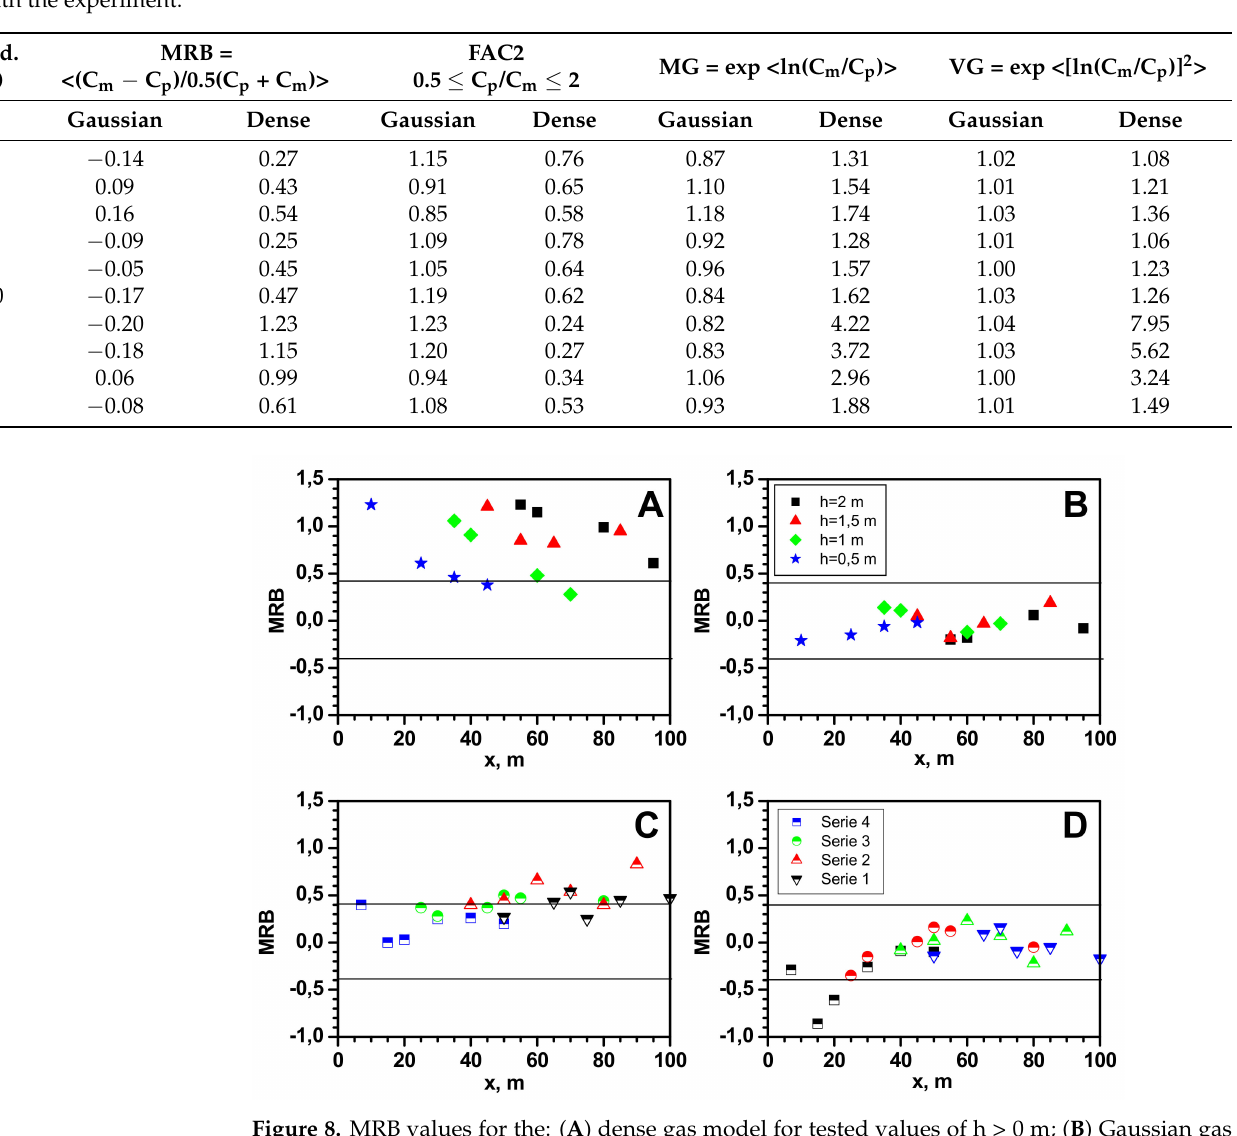
Figure 8. MRB values for the: ( A ) dense gas model for tested values of h > 0 m; ( B ) Gaussian gas model for tested values of h > 0 m; ( C ) dense gas model for h = 0 m; ( D ) Gaussian gas model for h = 0